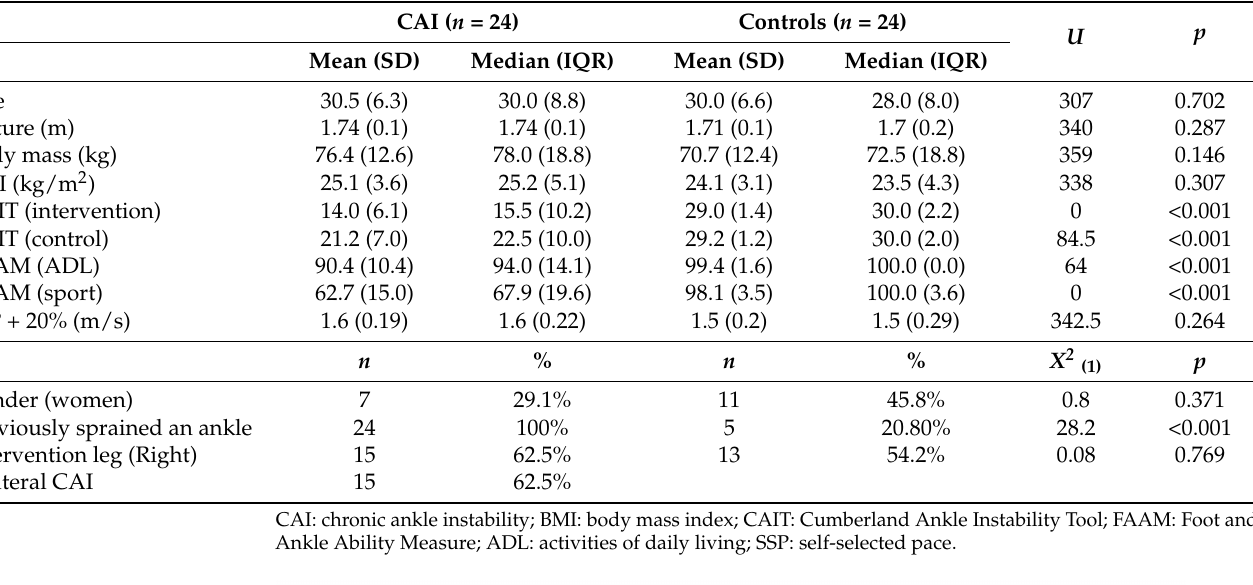
Table 1. Demographic characteristics of the participants.